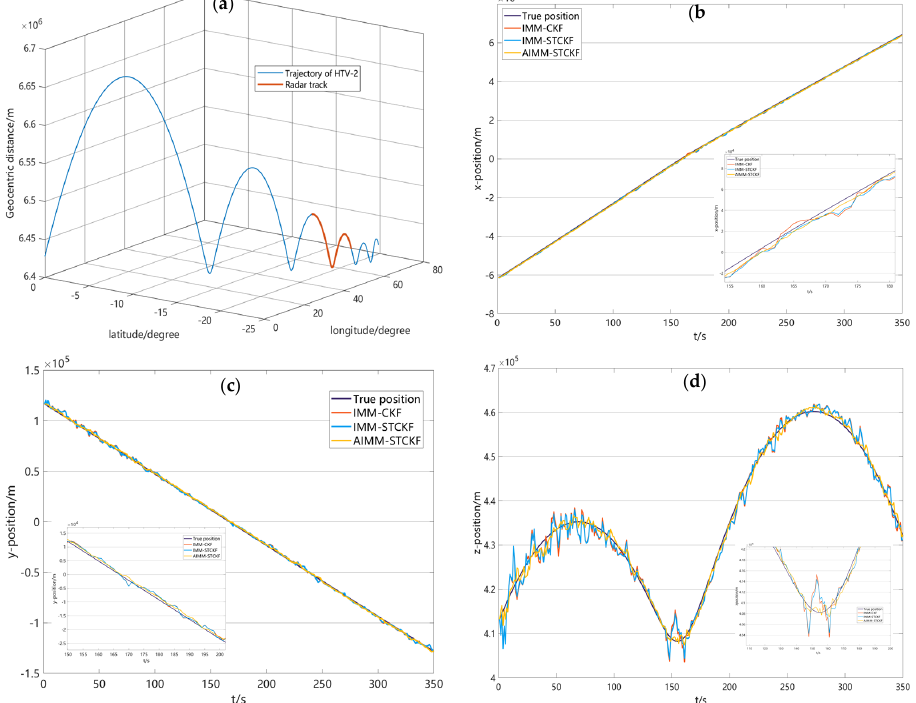
Figure 8. Trajectory tracking of hypersonic target. ( a ) Hypersonic target strong maneuver phase; ( b ) X-axis trajectory tracking; ( c ) Y-axis trajectory tracking; ( d ) Z-axis trajectory tracking.